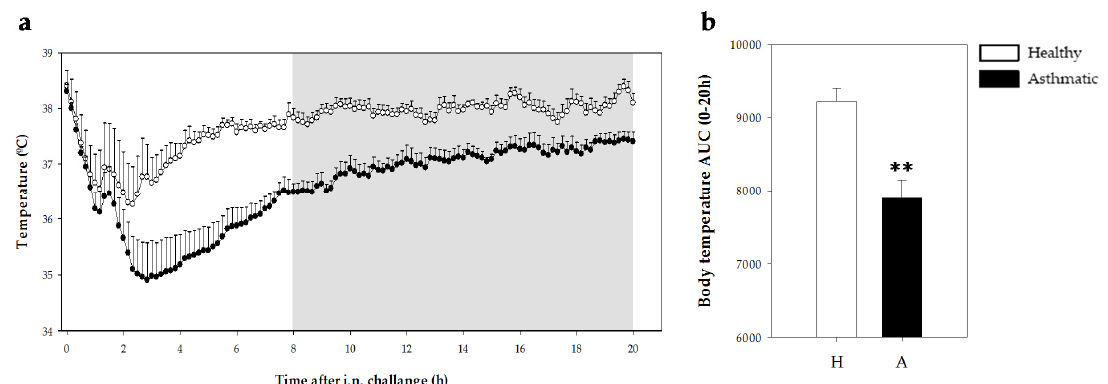
Figure 4. Body temperature 20 h after the i.n. challenge. ( a ) Body temperature assessed every 10 min (grey period corresponds to the dark period) in healthy (H, white bars) and asthmatic (A, black bars) rats. Statistical differences not included. ( b ) Area under the curve (AUC) of body temperature changes (from 34 °C) in the same period. Results are expressed as mean ± standard error (N = 9). Significant differences: ** p < 0.01 vs. healthy animals.